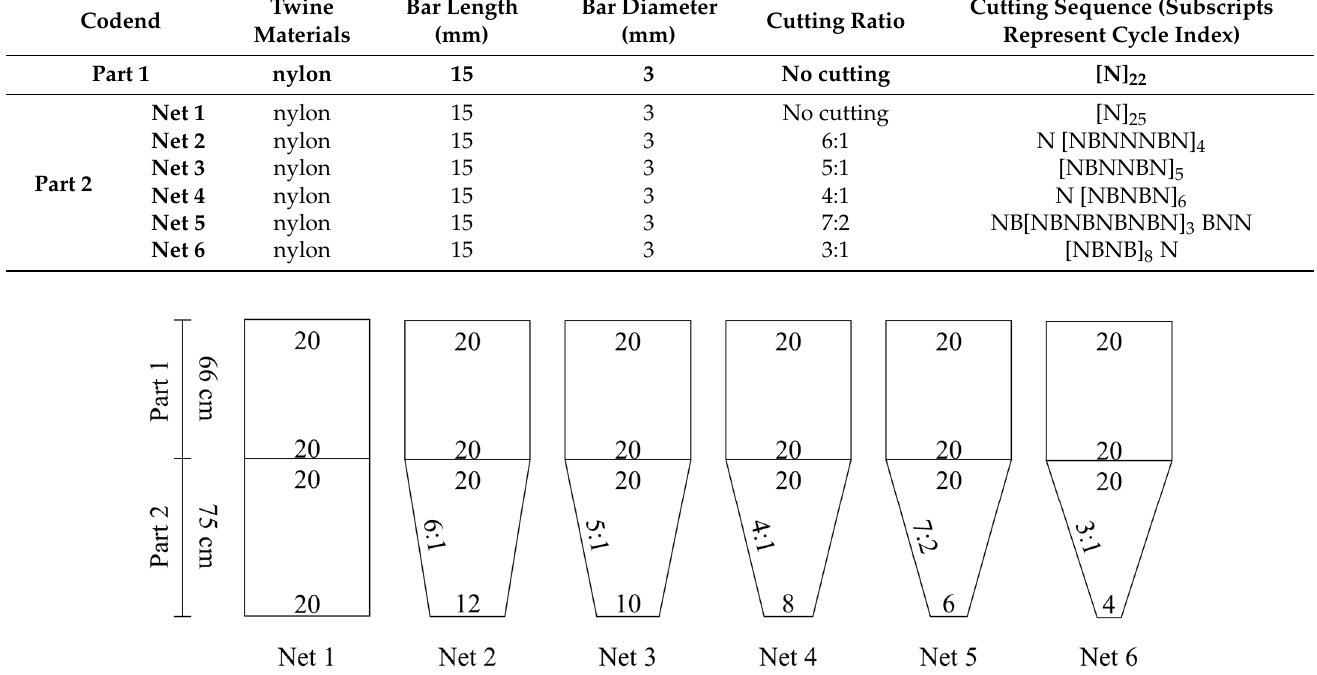
Figure 1. Design sketch of six codends.